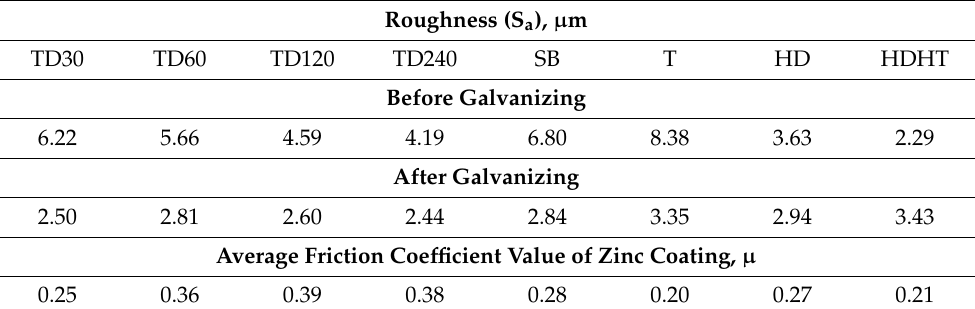
Table 3. The roughness and friction coefficient measured on the surface of the disc